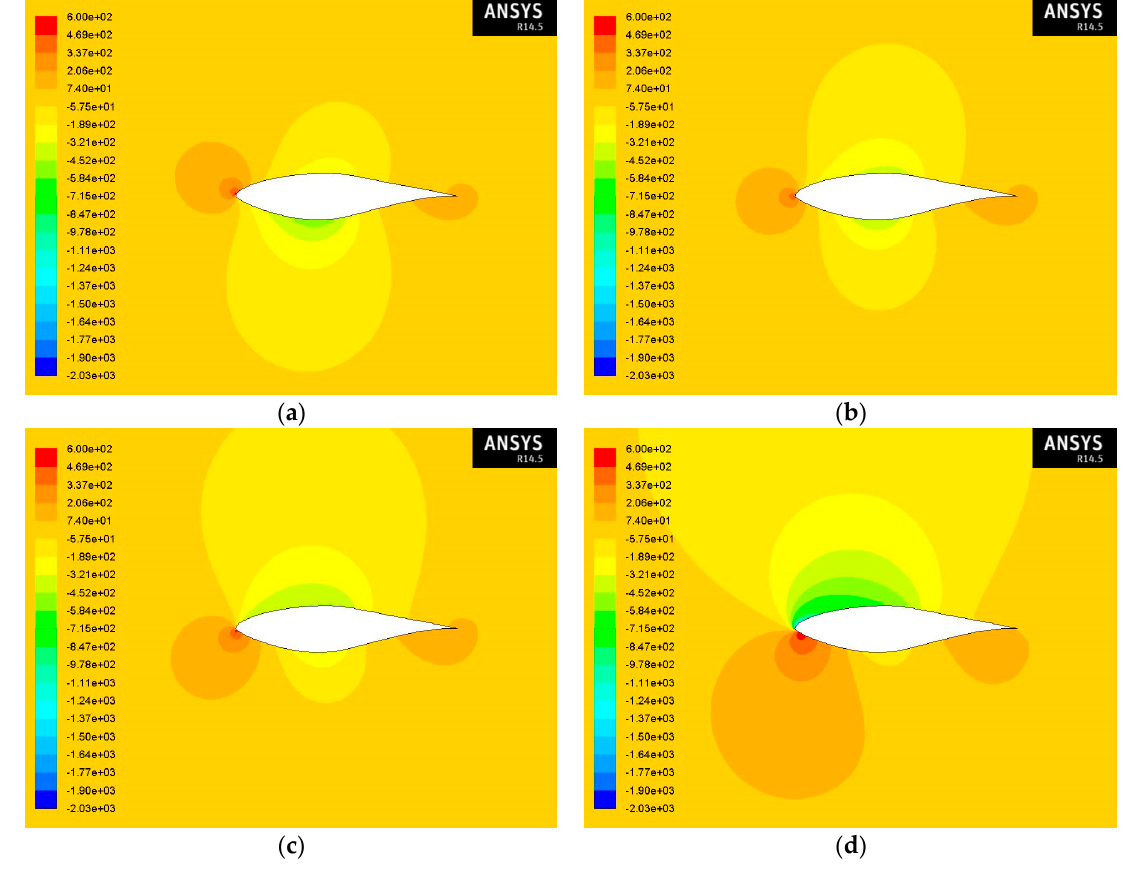
Figure 10. Contours of static pressure at ( a ) − 3°; ( b ) 0°; ( c ) 3°; and ( d ) 9° angles of attack at Re = 2 × 10 6 with the realizable k– ε turbulence model for an S809 airfoil for air flow.